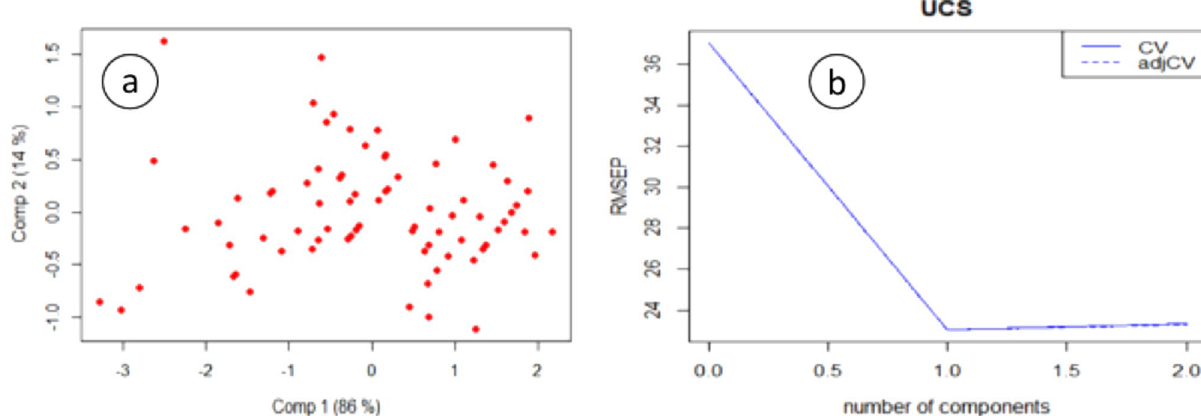
Figure 6. ( a ) Scatter plot of the components, ( b ) root mean square error plot.